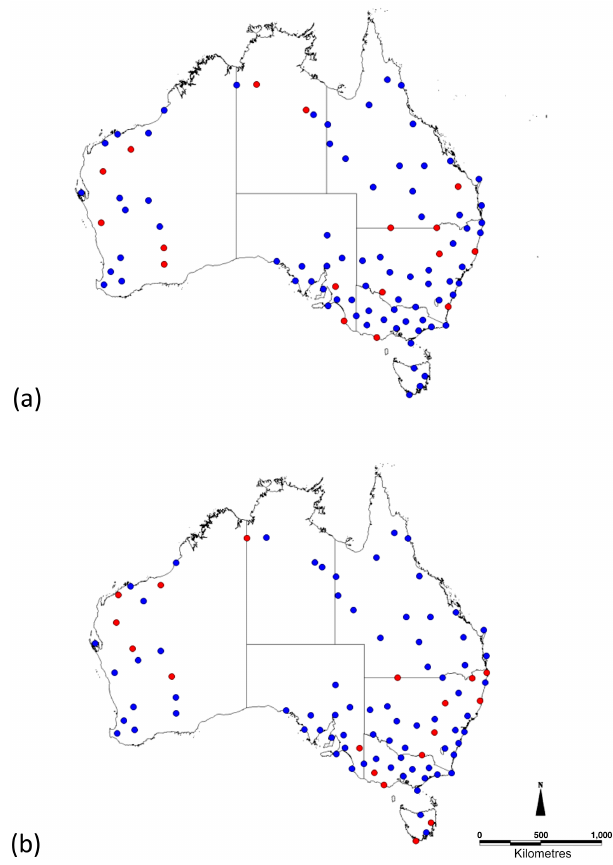
Figure 3. Stations (in red) with at least one statistically significant step change in (a) the 1-day and (b) 7-day annual maximum rainfall (using the CUSUM test with resampling).